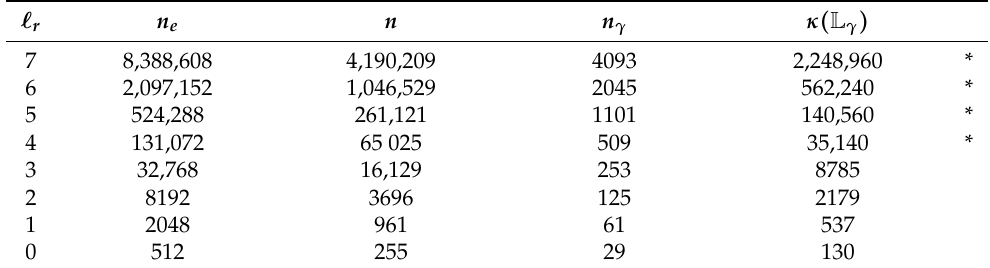
Table 3. Number of finite elements n e , number of unknowns n , number of unknowns corresponding to the interface n γ , and condition number κ ( L γ ) : (cid:96) r levels of uniform mesh refinements.